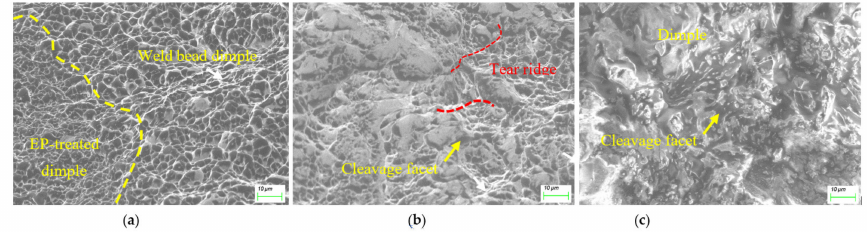
Figure 8. HAZ fracture morphology located at: ( a ) the EP centerline; ( b ) 0.8 mm; ( c ) 1.1 mm away from the EP